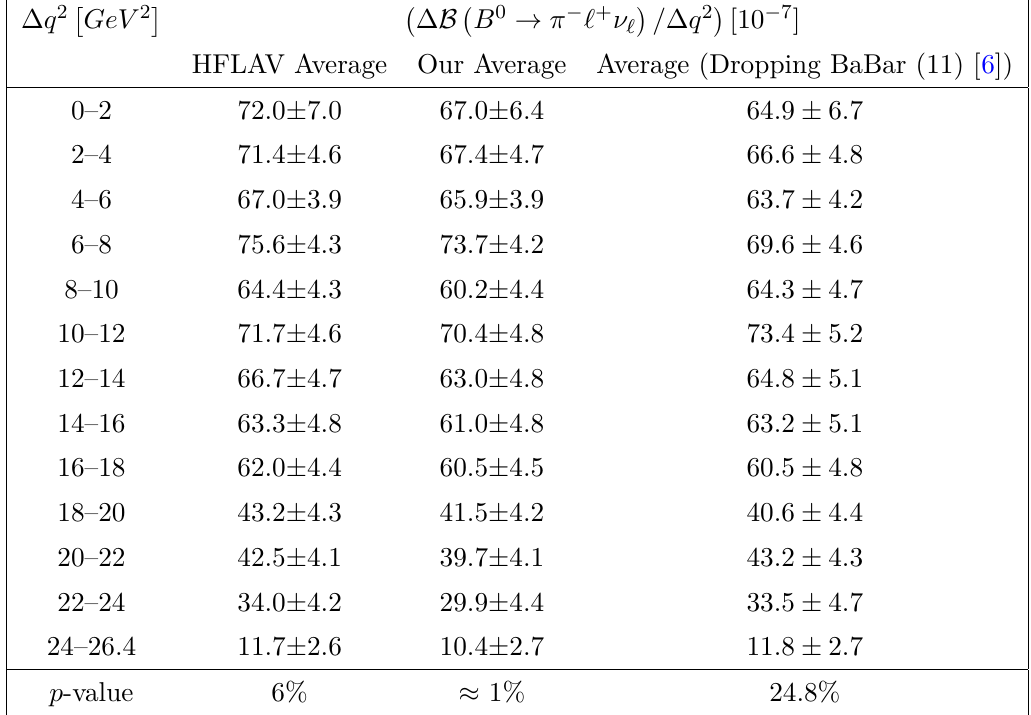
Table 1 . Comparison between our and HFLAV’s average q 2